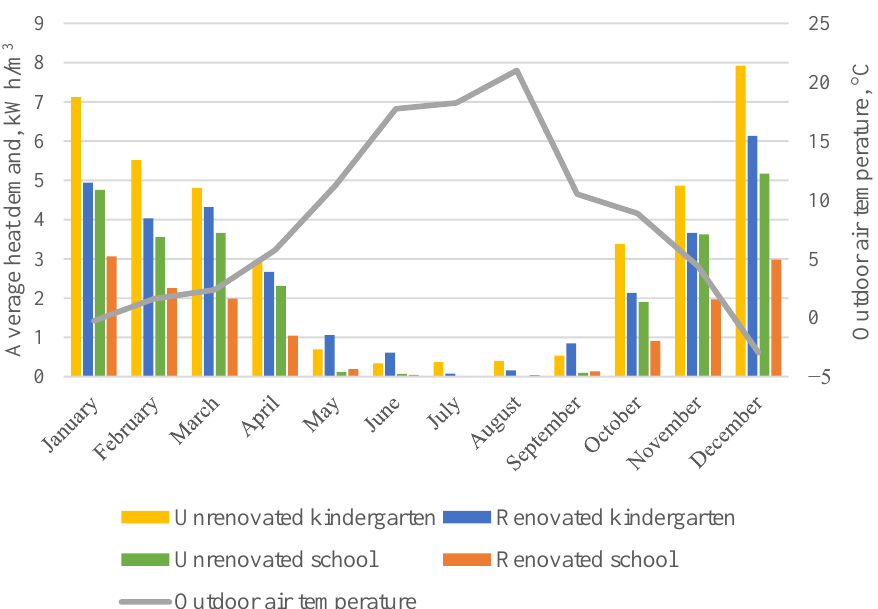
Figure 4. Relative average monthly heat consumption in renovated and unrenovated schools and